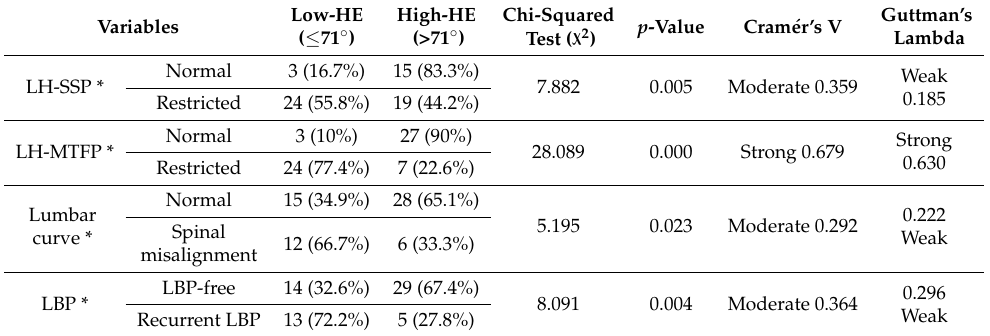
Table 3. Comparative analysis between low ( n = 8) and high ( n = 27) hamstring extensibility groups on sagittal pelvis position and spinal curve in female soccer and basketball players Table 4. Variables associated (expected frequency greater than 5) with high or low hamstring extensibility in male soccer and basketball players.